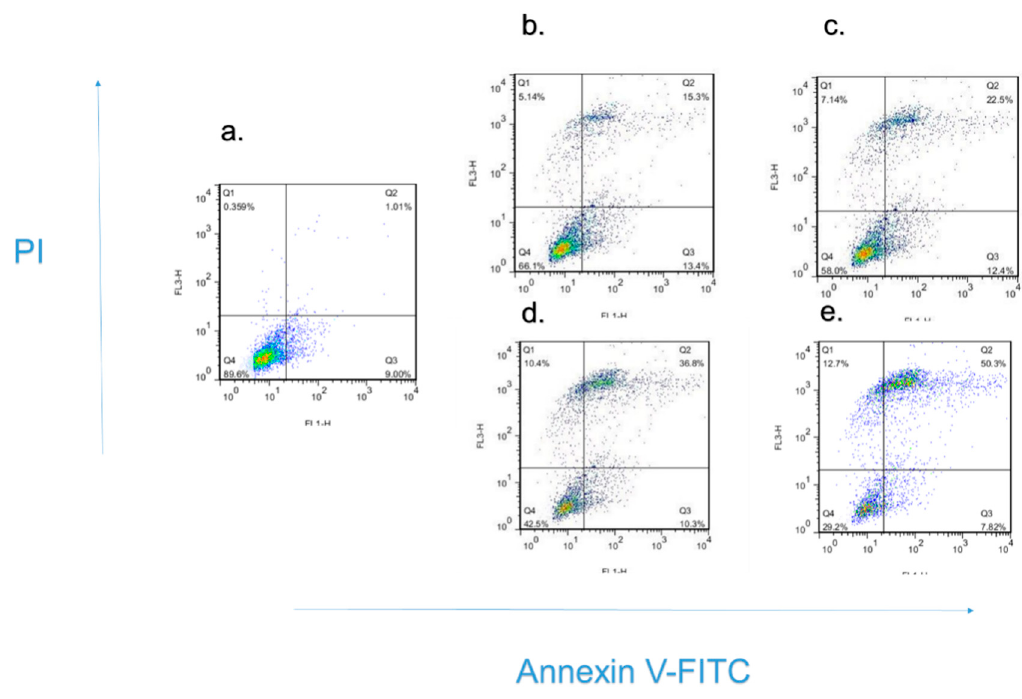
Figure 2. Compound H20 induced apoptosis in Hela cells with the density of 0, 2.0, 4.0, 6.0, 8.0 µ M ( a – e ). HeLa cells were treated with for 24 h. Values represent the mean ± S.D, n = 3, p < 0.05 versus control. The percentage of cells in each part was indicated.